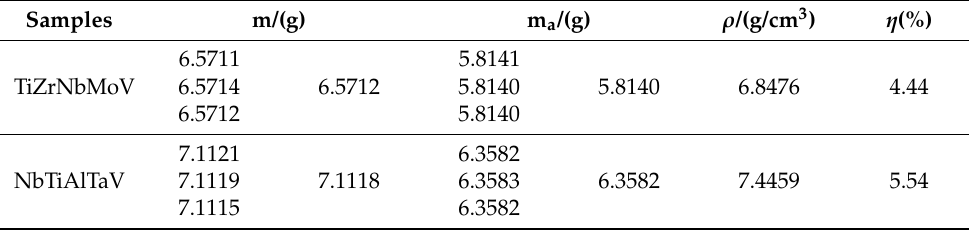
Table 2. Chemical composition of different points in TiZrNbMoV and NbTiAlTaV alloys.